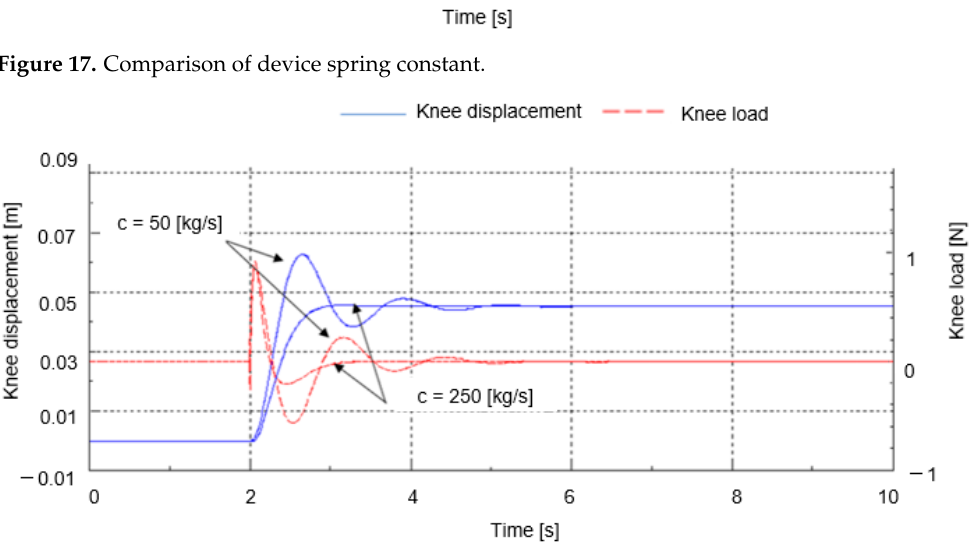
Figure 17. Comparison of device spring constant.